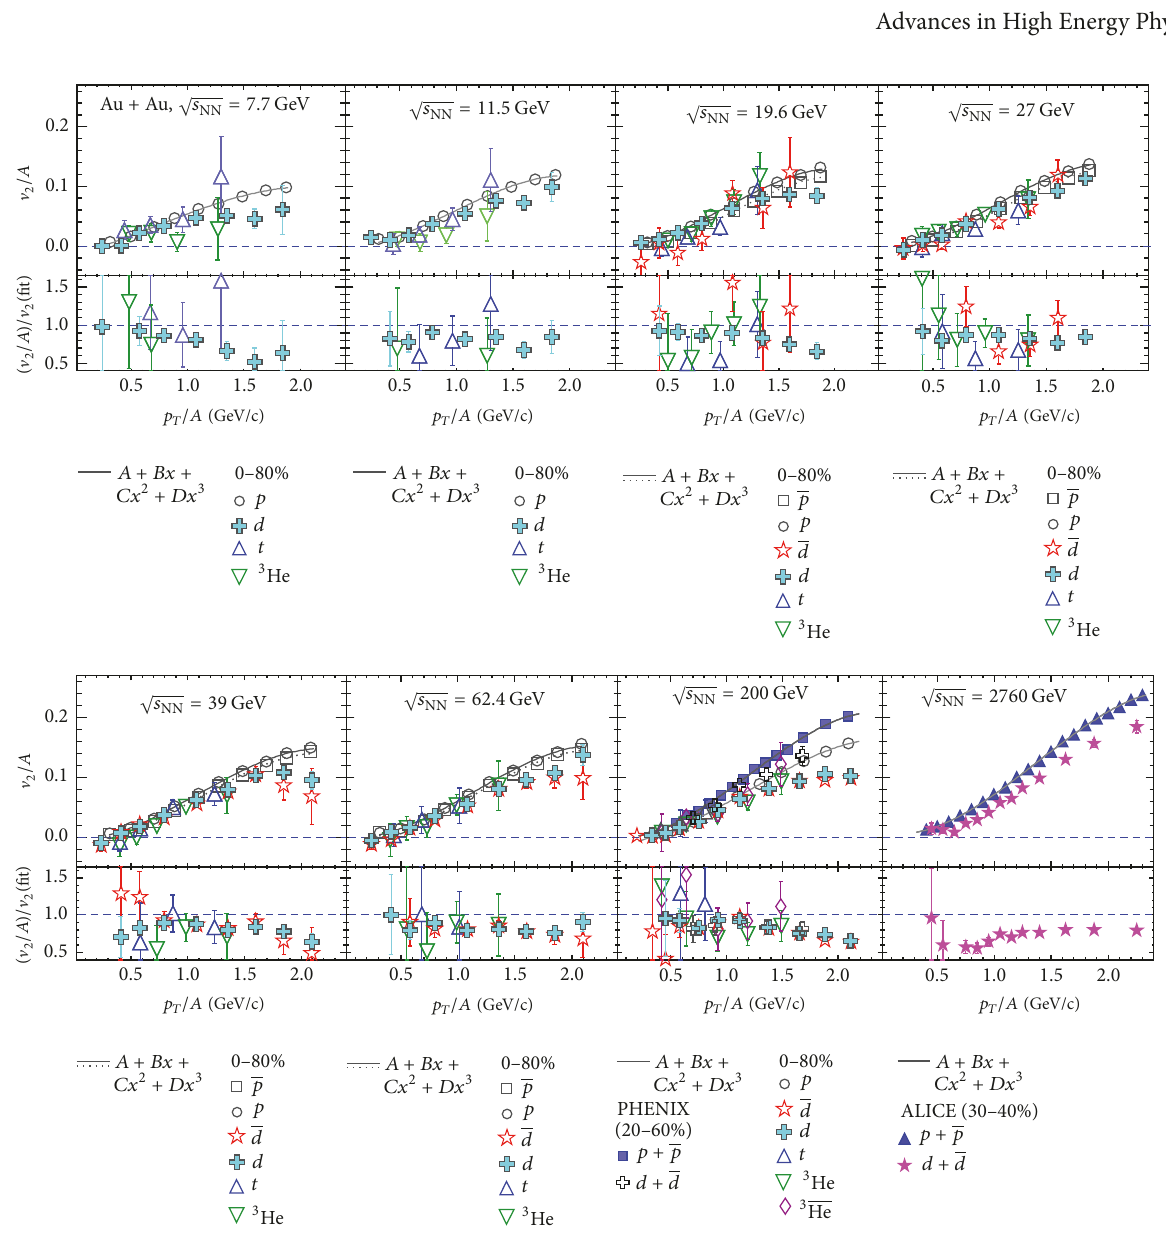
Figure 6: Atomic mass number scaling V 2 /𝐴 of light nuclei as a function of 𝑝 𝑇 /𝐴 for STAR (0–80%), PHENIX (20–60%), and ALICE